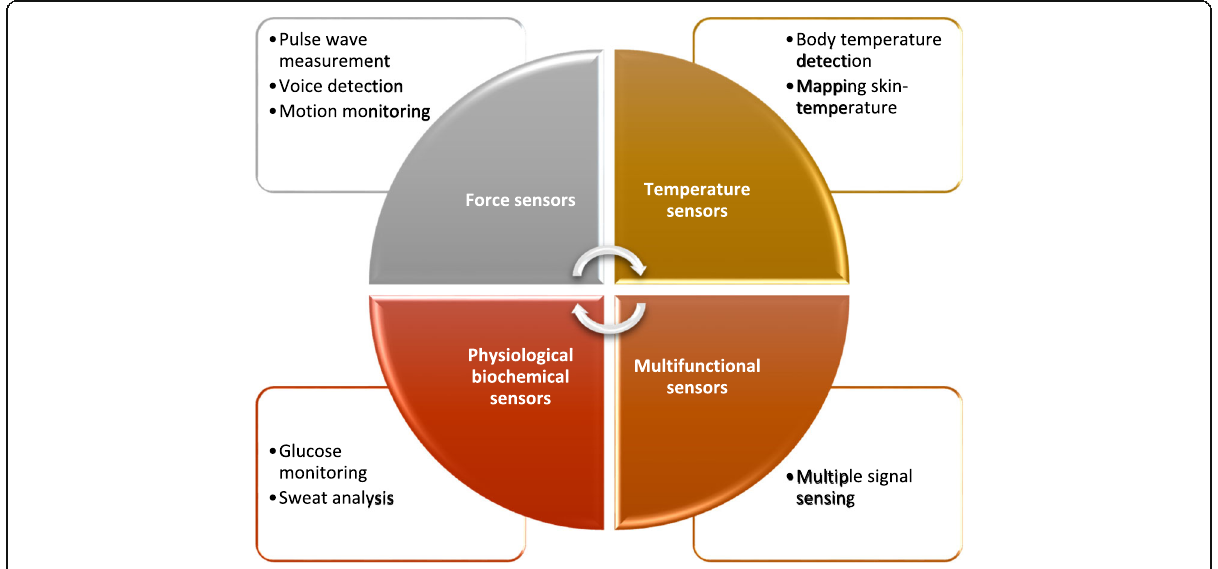
Fig. 1 A visual summary of recent development of wearable electronics for monitoring human health